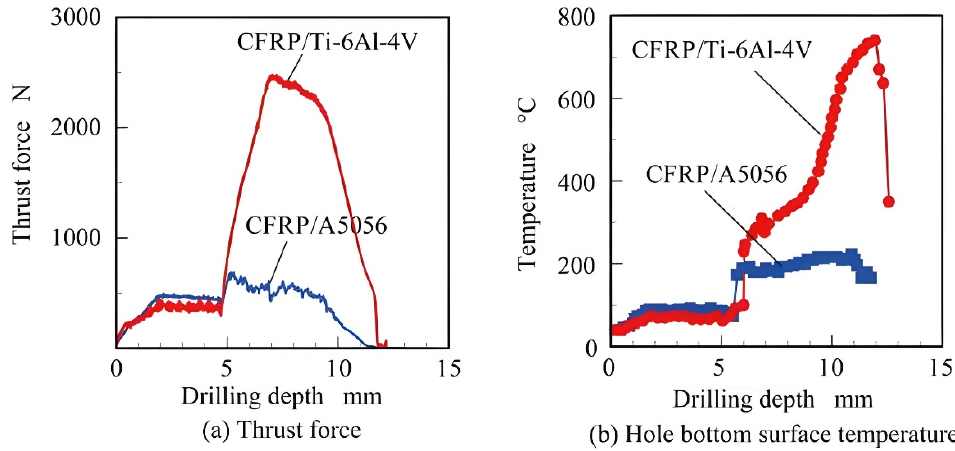
Figure 9. ( a ) Thrust force and ( b ) drilling temperature evolution as a function of drilling depth dur- ing the drilling of CFRP/Al and CFRP/Ti stacks [138].